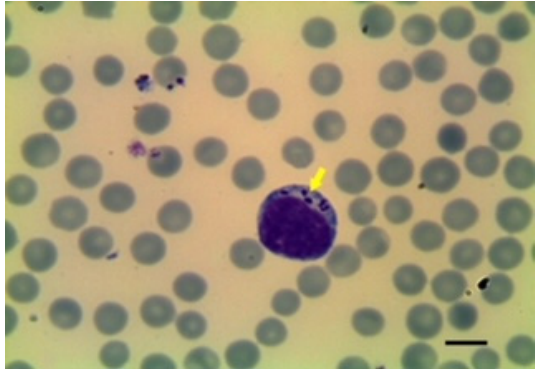
Figure 5. T. ovis schizont in blood smear. Image courtesy of Professor Khaled El-Dakhly, Beni-Suef University,